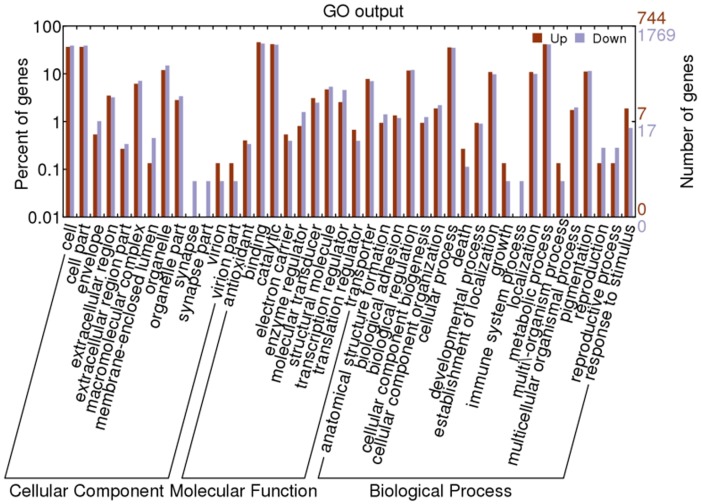
GO categories of predicted target genes of differentially expressed miRNAs at 72 h post-inoculation.